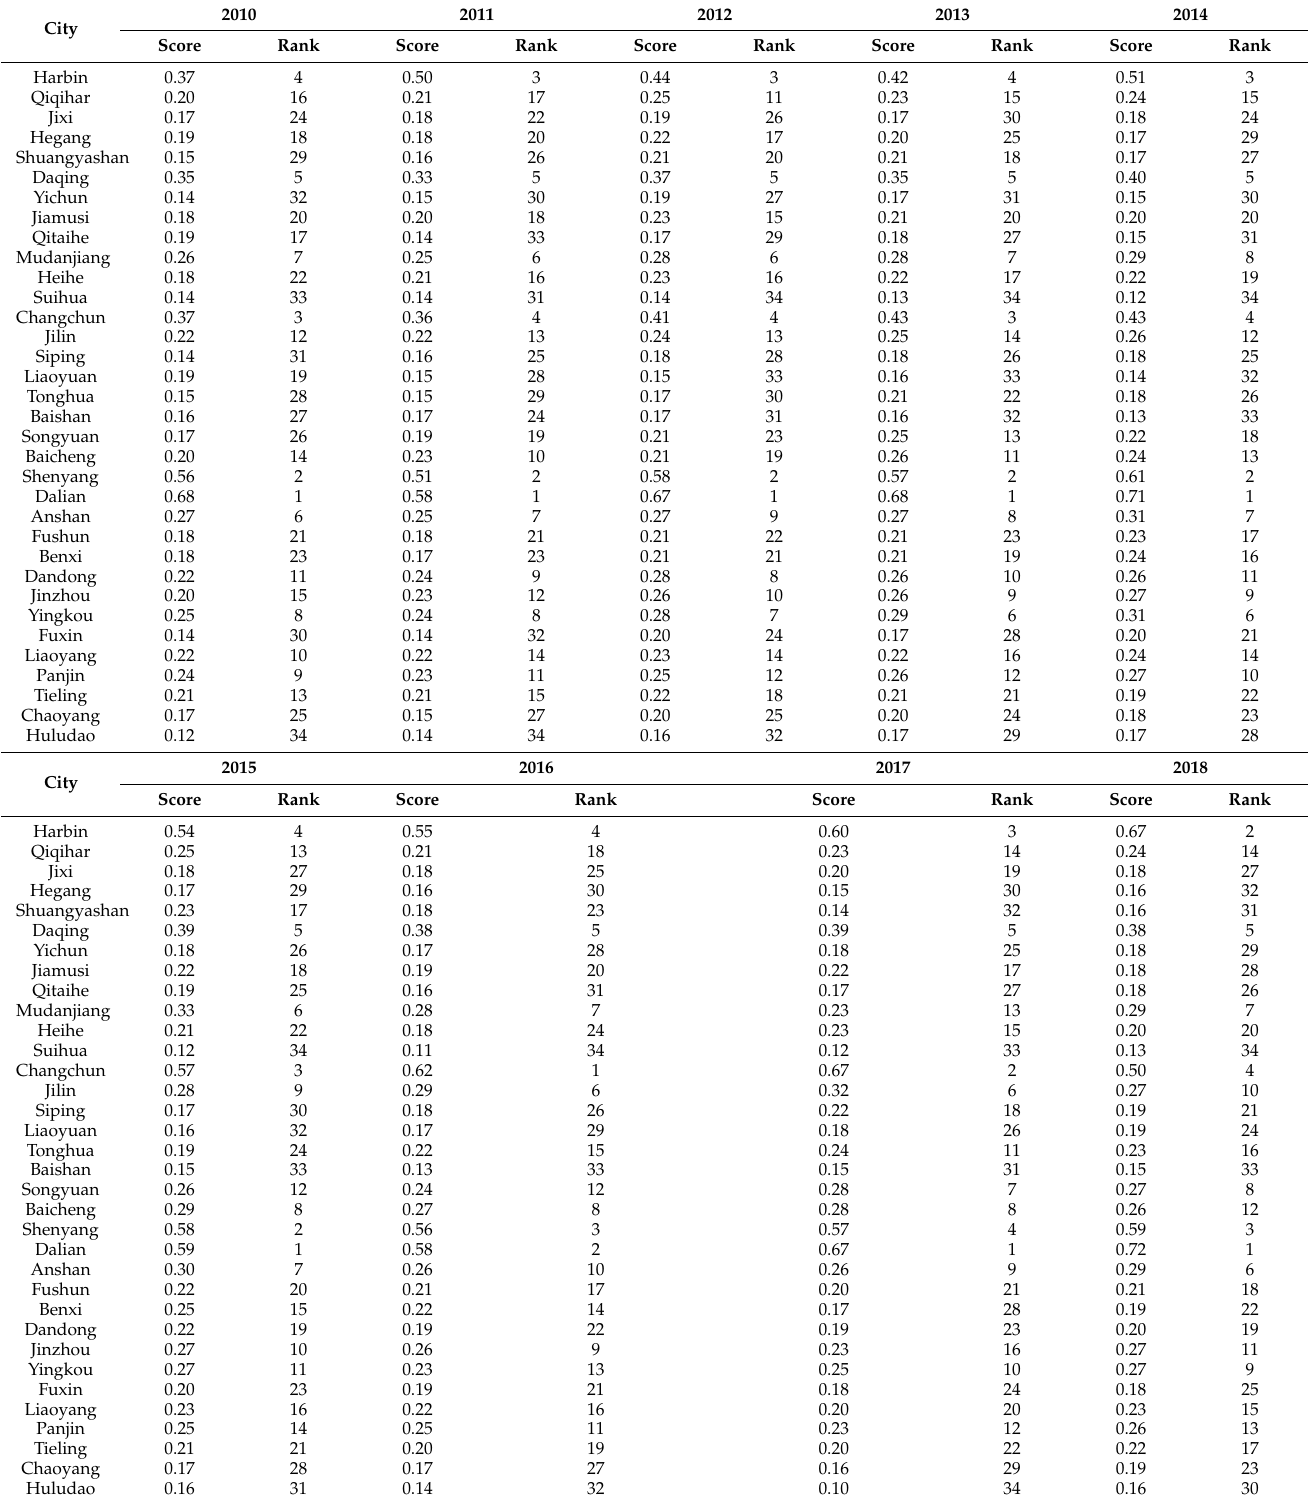
Table 5. Scores and ranks of urban vitality in three northeastern provinces of